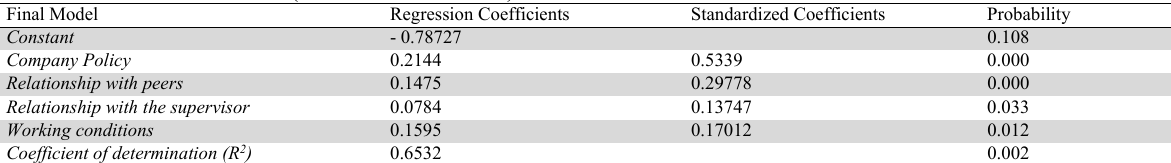
Coefficients of the final model (affective commitment) Final